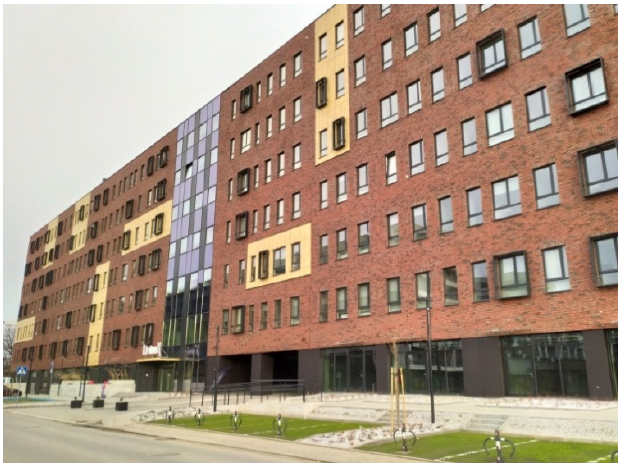
Figure 15. Student Residence Hall Livinn Kraków, renovation and modernisation by Unibep (Item 10, Figure 1) (photo by E. Latusek).